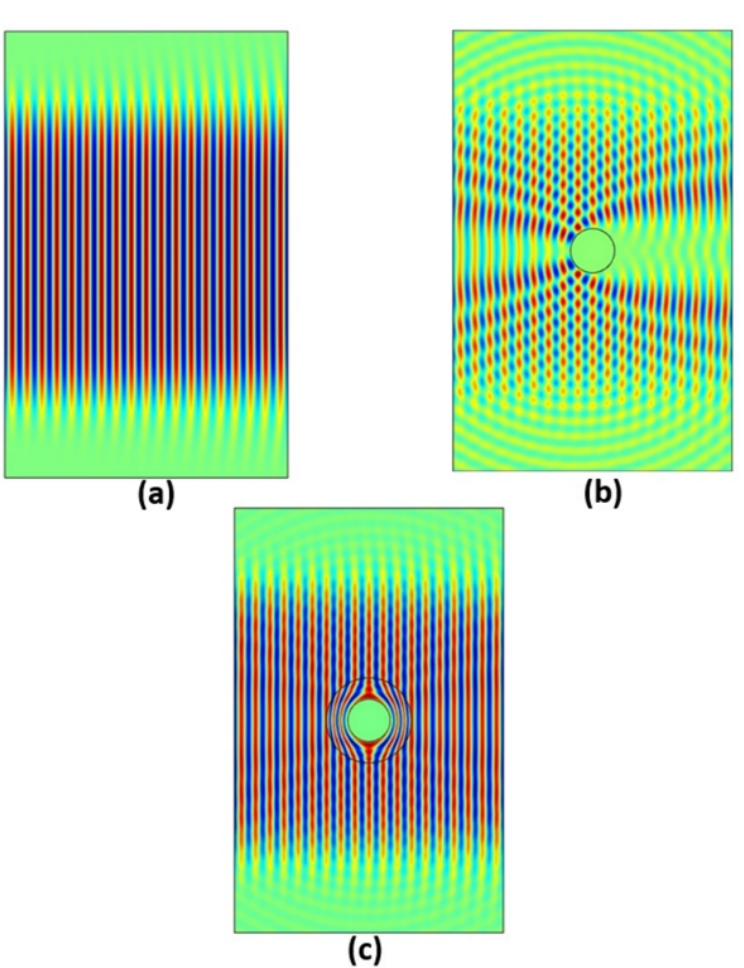
Figure 4. Full wave COMSOL simulations demonstrating electromagnetic cloaking of a concealed ob- ject. ( a ) an unperturbed TE wave in the free space, ( b ) a perfect electric conductor (PEC) is introduced, and significant scattering properties are observed, ( c ) a metamaterial shell is introduced around the cloaked object, and the wave bend around the object thus mitigates the scattering